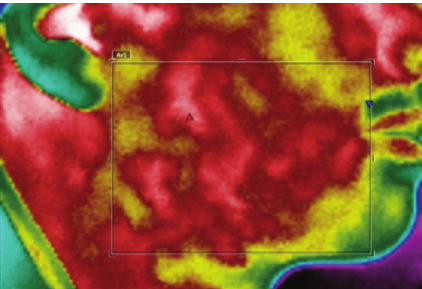
Figure 17: Temperature measurement of a face having an injury.